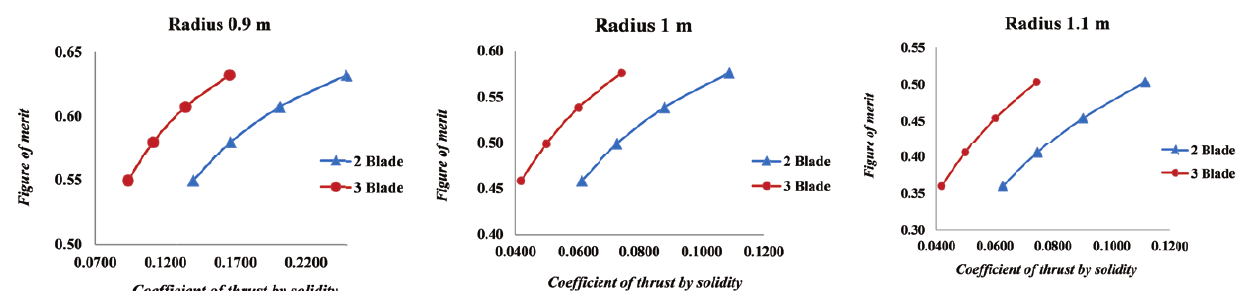
Figure 8. Blade loading coeffi cient, C T / σ and Figure of Merit, FM comparison for 2-blade coaxial system and 3-blade coaxial system at various radius for 900 RPM to 1200 RPM